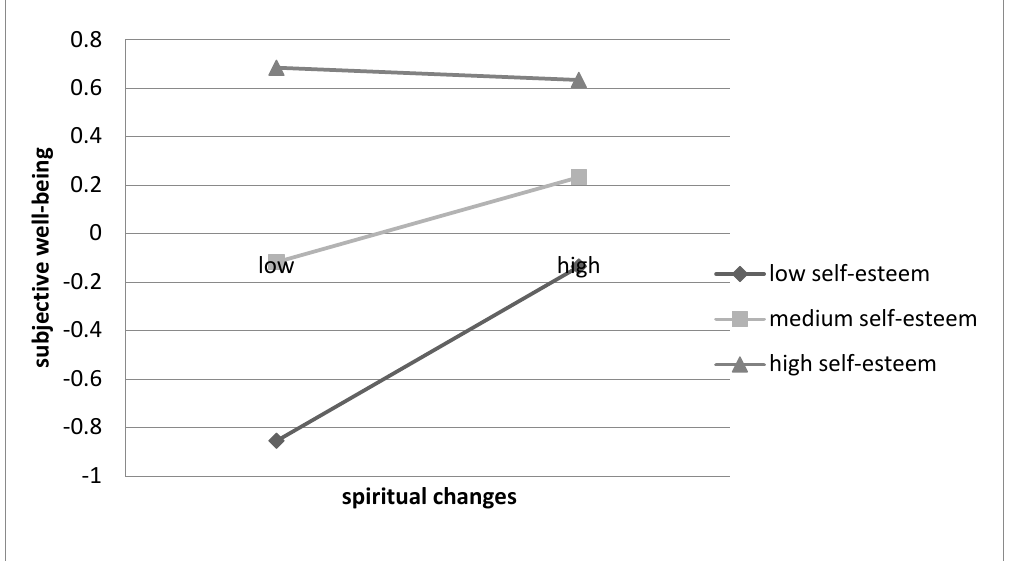
-1-0.8-0.6-0.4-0.200.20.40.60.8 Figure 2. A Graphical Representation of Moderation Effect of Spiritual Changes on Subjective Well-being at Low ( − 1 SD ), Moderate ( M ) and High (+1 SD ) Levels of Self-esteem.